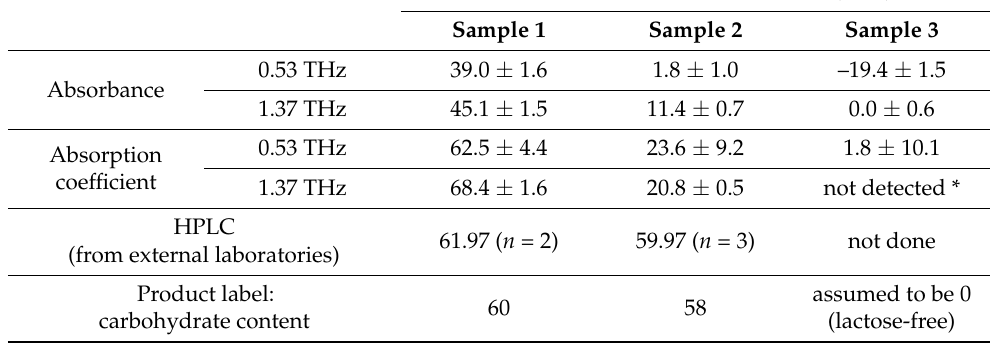
Table 3. Mean predicted concentration of lactose anhydrous in infant formula samples using 0.53 THz and 1.37 THz absorption peak area from THz-TDS measurements conducted in nitrogen atmosphere, mean concentration obtained from HPLC measurements in external laboratories and product nutri- tional